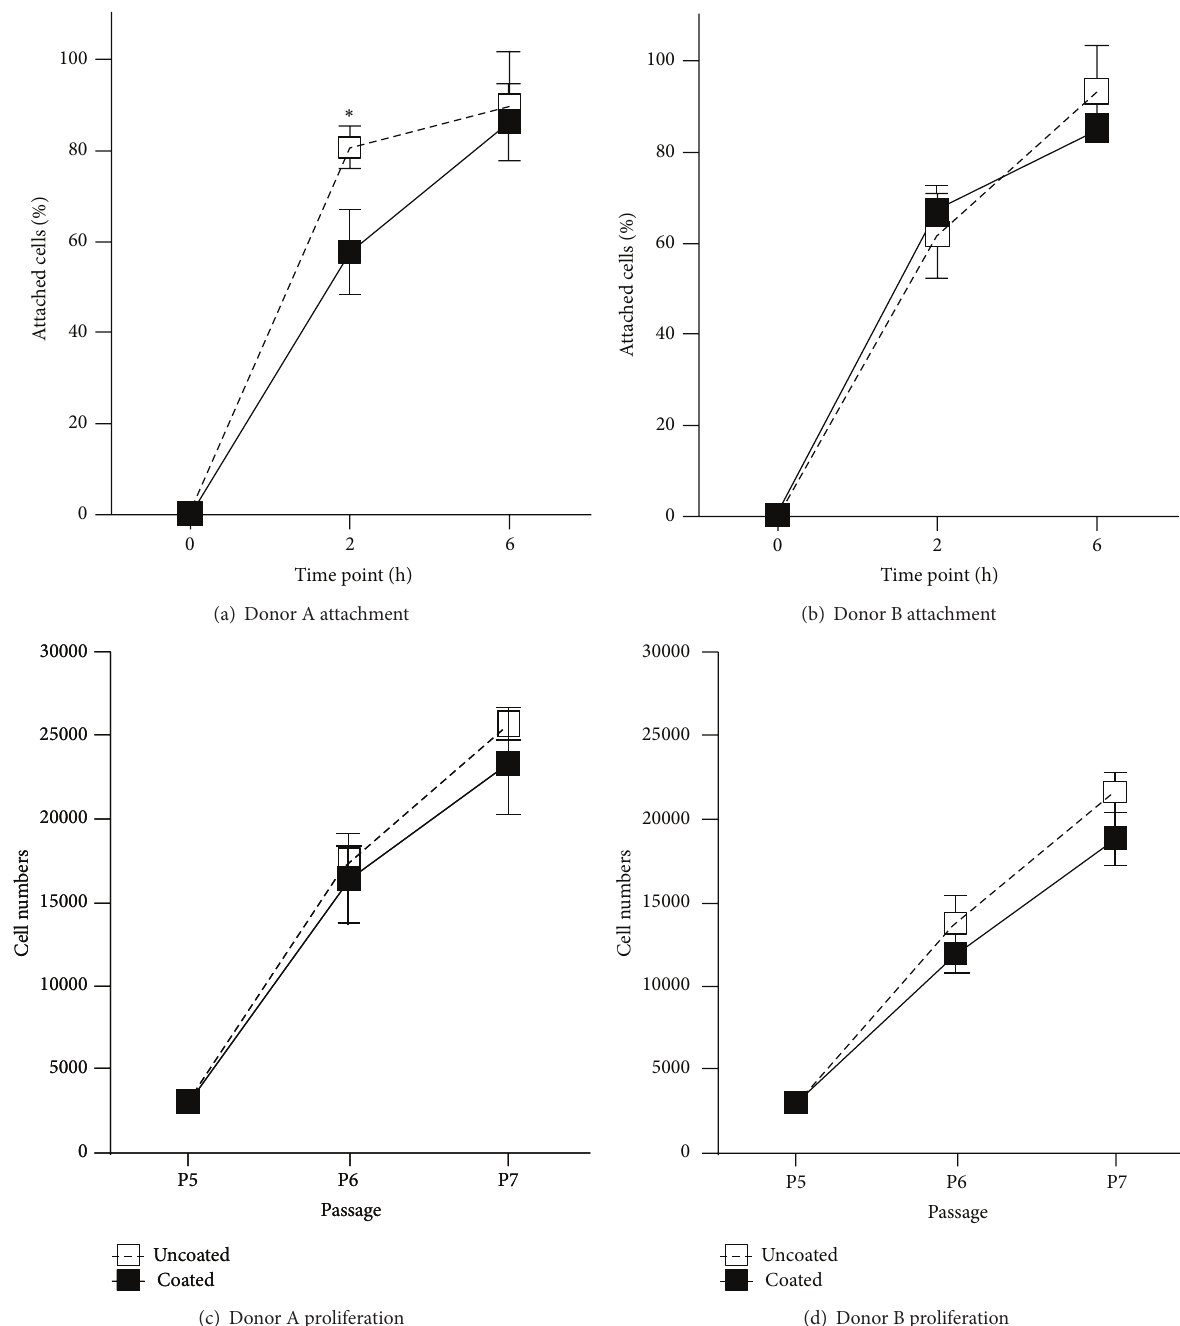
Figure 3: Cell attachment and proliferation. Percentage of attachment of hMSCs from (a) Donor A and (b) Donor B on uncoated and keratin- coated TCPS surfaces over 2 and 6h; 𝑛 = 3 , ∗ 𝑃 < 0.05 . Cumulative cell numbers of hMSCs from (c) Donor A and (d) Donor B on uncoated and keratin-coated TCPS surfaces over 2 passages; 𝑛 = 6